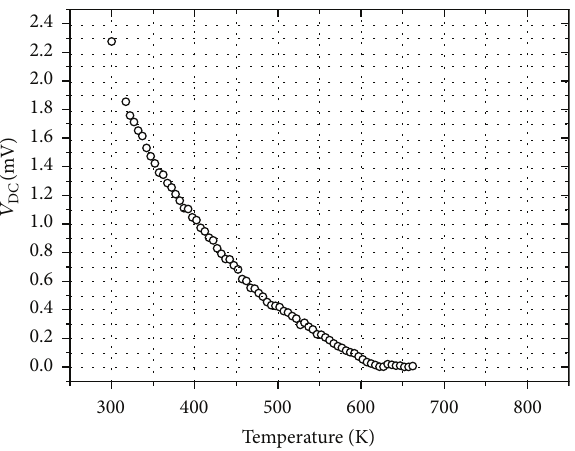
Figure 6: Frequency dependence of DC voltage induced by applied radiofrequency AC